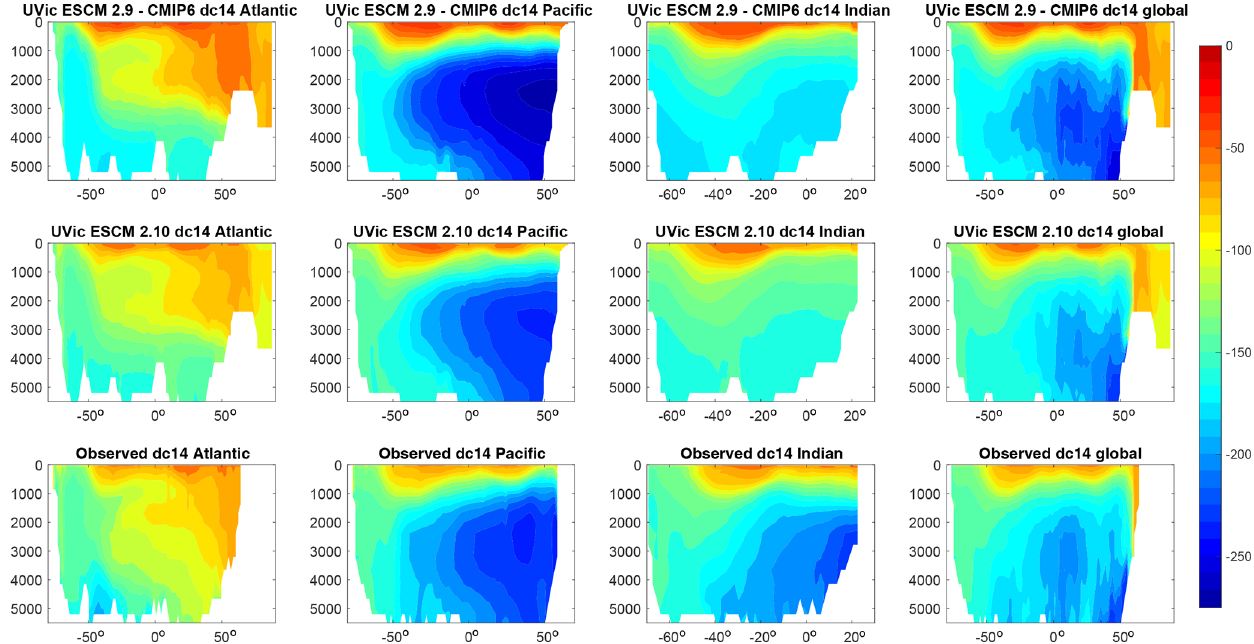
Figure 12. Ocean section of (cid:49) C14 (in ‰) for the Atlantic Ocean including the Arctic Ocean (left column), the Pacific Ocean (middle left column), the Indian Ocean (middle right column) and the global average (right column) compared to observations (Key et al., 2004). From top to bottom, what is shown are the published UVic ESCM version 2.9 by Eby et al. (2013) spun up and forced with CMIP6 forcing, the UVic ESCM version 2.10, both as a mean of the period 1980–2010, and the observed ocean